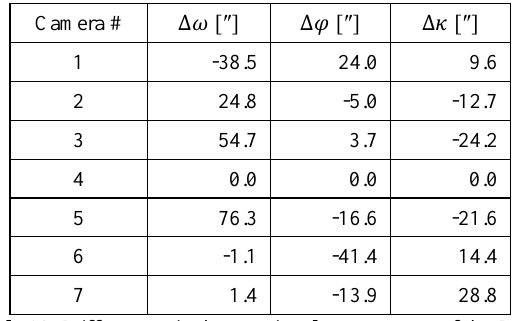
Table 10. Differences in the rotational components of the ROPs